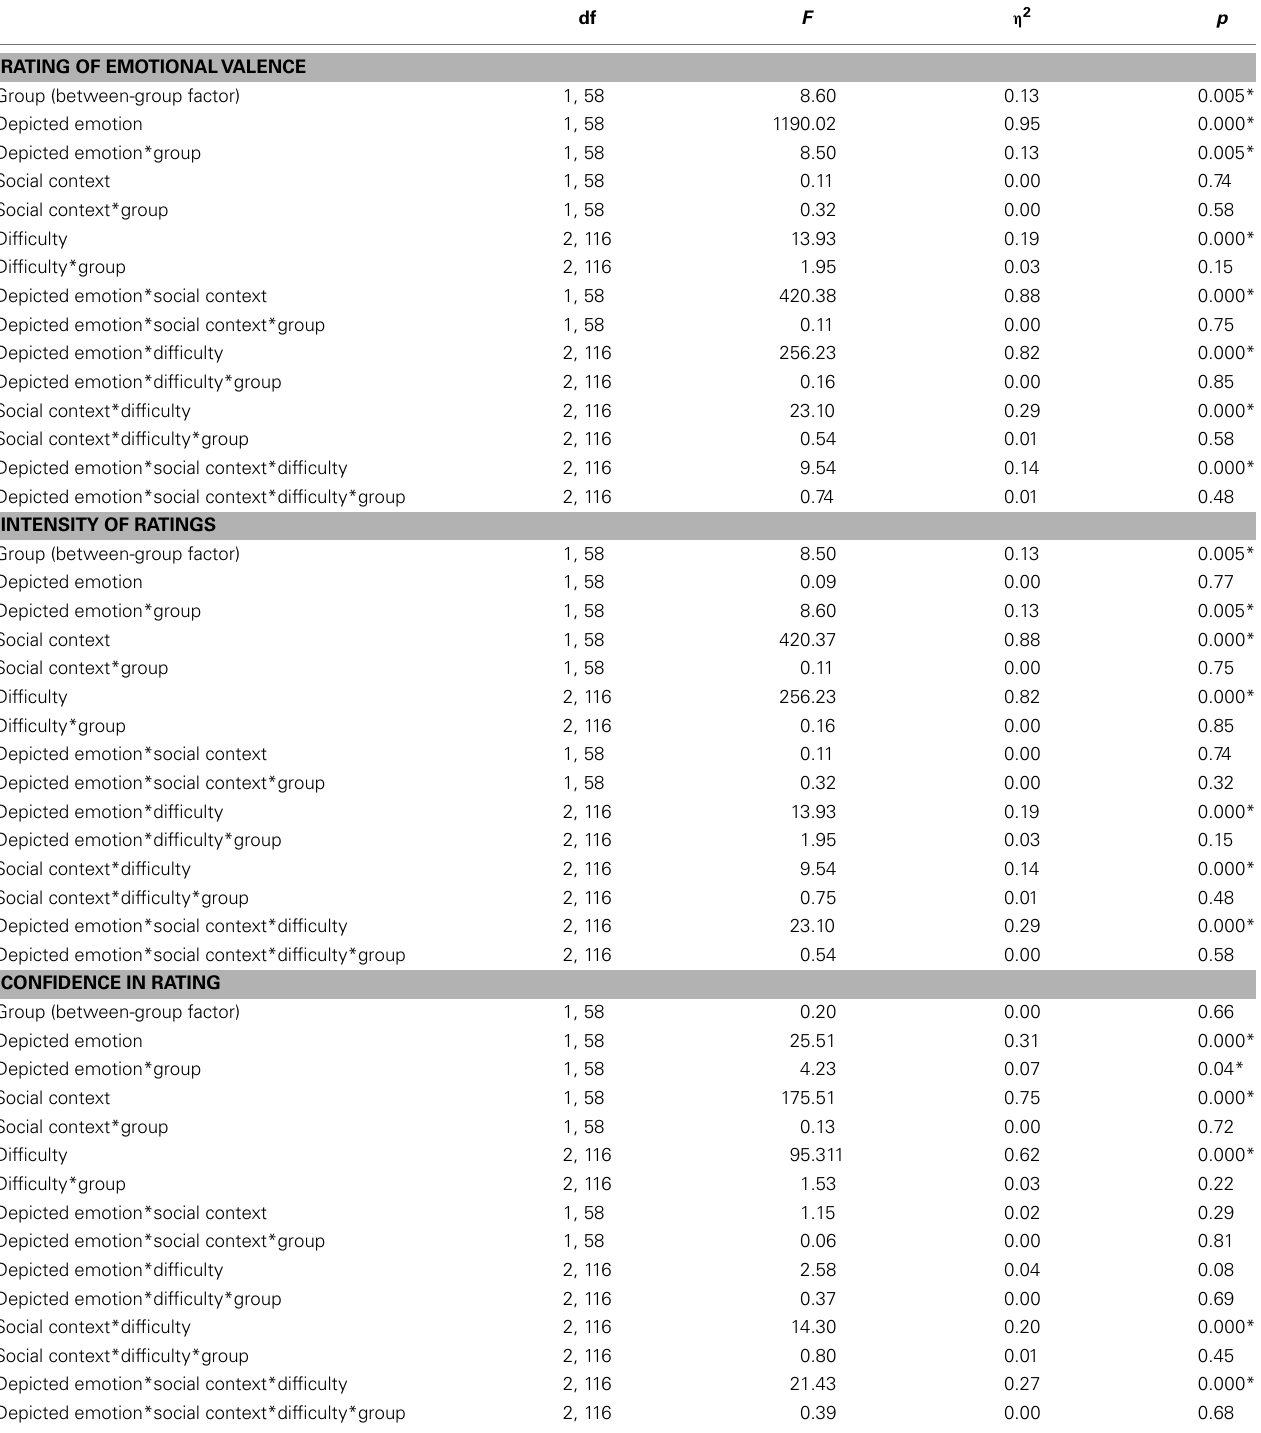
Table 1 | Statistical data of depicted emotion × social context × difficulty repeated-measuresANOVA for rating of valence, intensity of ratings, and confidence rating in ratings